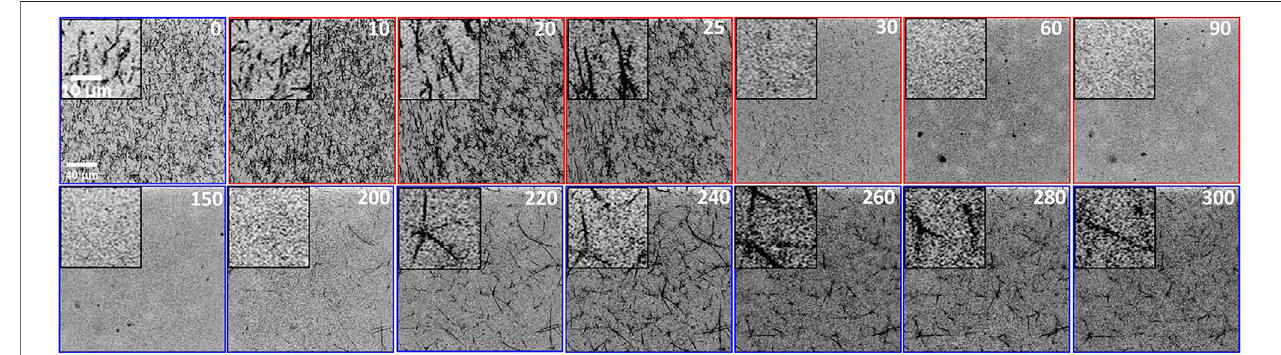
FIGURE3| Laserscanningconfocalmicroscopyimages of fl uorescent-labeled actin fi laments comprising actomyosinnetworkssubject to insitu cyclingof[Mg 2+ ] and [K + ].The buffer exchangeprogram isidentical tothatdone for microrheology measurements. Times are listed inminutes in thetop right corner ofeach image. Scale barsshownfor t (cid:1) 0applytoallimagesandare40 μ mformainimagesand10 μ mforthezoomed-ininsets.Colorsaroundeachimageindicatethebufferconditionsasin Figure 2 [blue (cid:1) low-salt (1 mM MgCl 2 , 50 mM KCl), red (cid:1) high-salt (500 mM MgCl 2 , 200 mM KCl)]. At t (cid:1) 0 the network is homogeneous and comprised of thin fi bers. Switching to “ high-salt ” leadstothickening (i.e.,bundling) of fi bers ( t (cid:1) 10,20, and 30)followedbynetworkdestruction ( t (cid:1) 60,90, and 150). Re-introducing “ low- salt ” buffer leads to slow re-emergence of networks that are substantially more bundled that the initial low-salt network ( t (cid:1) 200, 240, 280, and 300). Each 512 × 512 inverted greyscale image is captured using an A1R laser scanning fl uorescence confocal microscope with 60x 1.4 NA objective and 561 nm laser line.